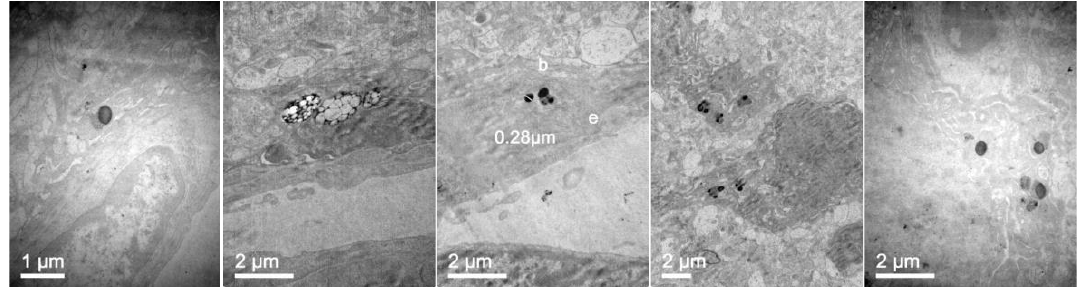
Figure 16. TEM images of the brain in mice 24 h after administration of elosulfase alpha-NLC passing blood-brain barrier (BBB) ( three left images ), in the interior of the astrocytes ( fourth image ), and neurons ( fifth image ).